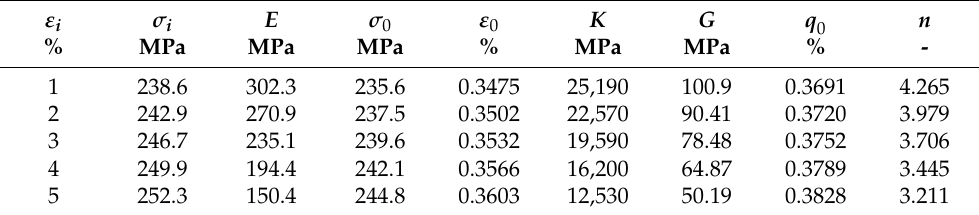
Table 2. Dependence of material parameters on selection of calibration point ( ε i , σ i ) in case of compressible